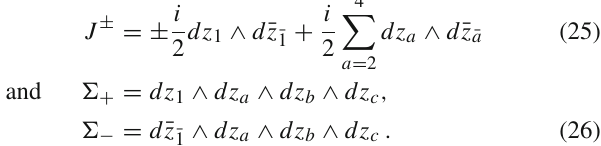
corresponds to 1